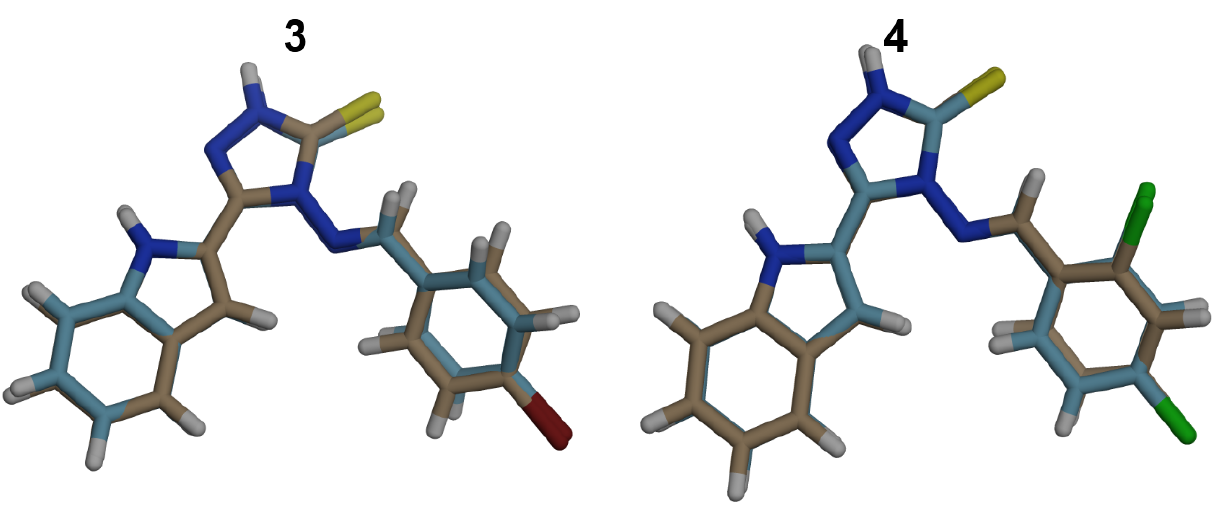
Figure 11. Overlay of the optimized with experimental structures for the studied compounds.